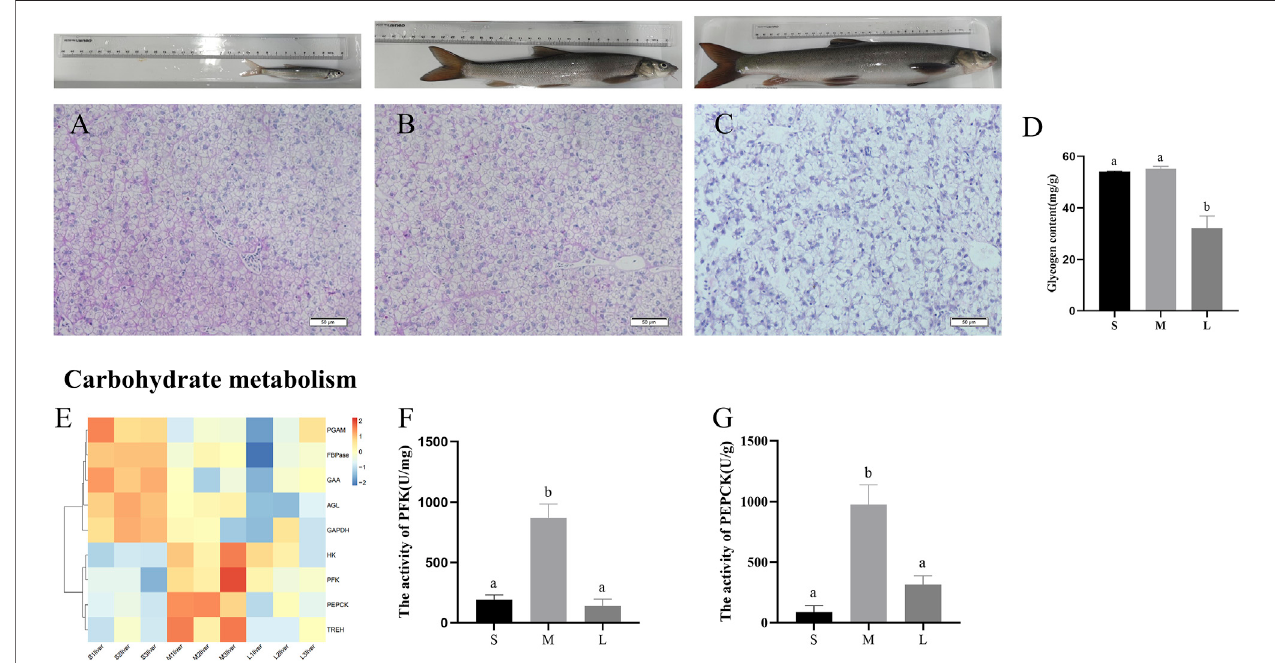
FIGURE 5 | PAS staining and glycogen content in liver of S. prenanti at three stages. (A) liver PAS staining of juvenile. (B) liver PAS staining of young, (C) liver PAS stainingofadult, (D) thecontentofliverglycogen, (E) heatmapsoftheDEGsinvolvedinglycolysisandgluconeogenesis, (F) TheactivityofPFK(U/mg), (G) Theactivityof PEPCK (U/g). Data are shown as means ± SEM. Three biological replicates were used. And groups denoted by different letters represent a signi fi cant difference at p < 0.05. The juvenile, young and adult of S. prenanti denoted as S, M, and L,